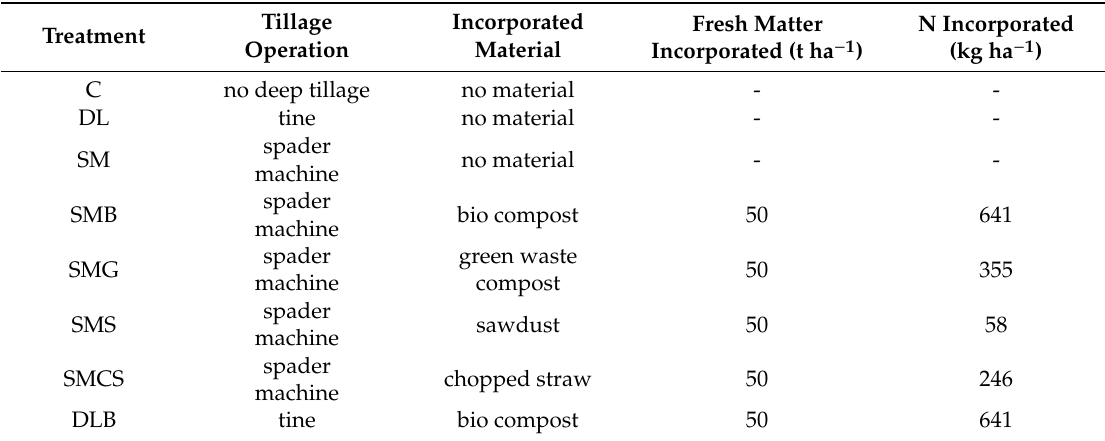
Table 2. Overview of the di ff erent treatments with amounts of incorporated materials in t ha − 1